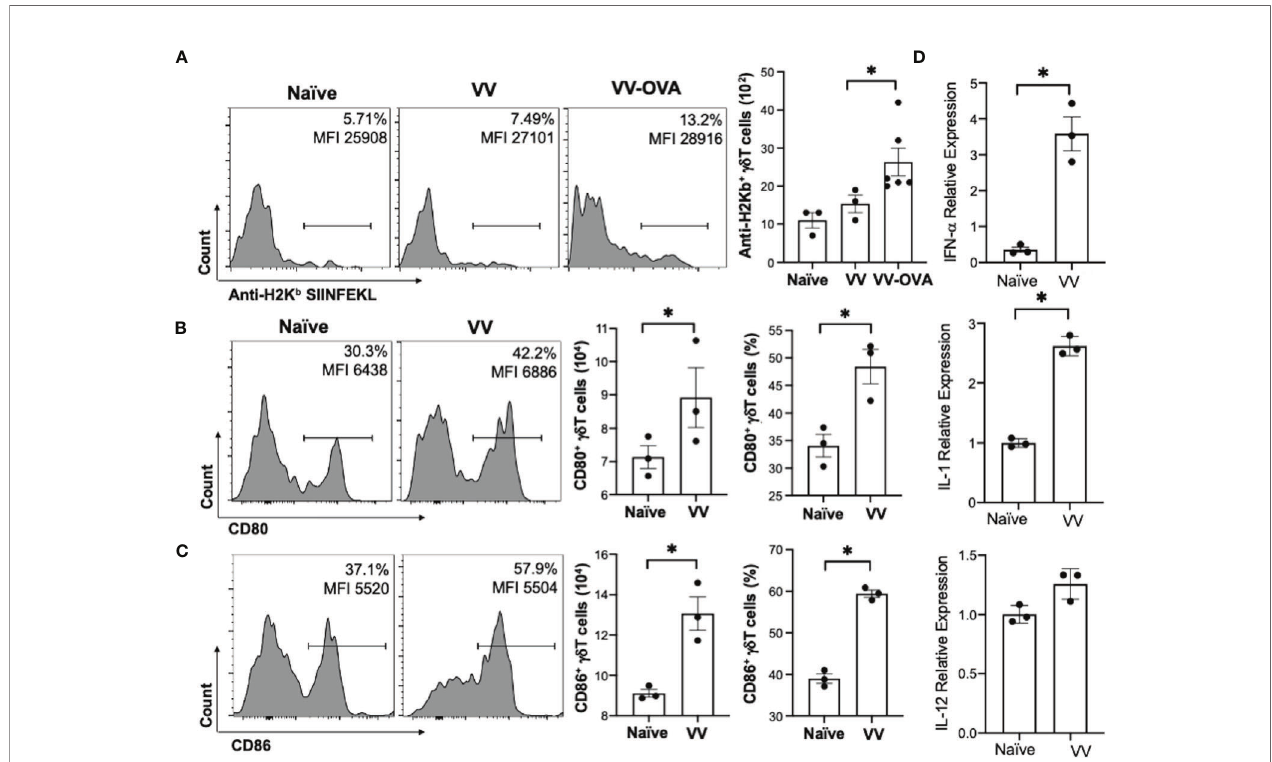
FIGURE 3 | VV activates gd T cells to present peptide on MHC-I and upregulate CD80/CD86 expression. C57BL/6 mice were inoculated intraperitoneally with 5 x 10 6 pfu of VV or VV encoding OVA (VV-OVA). (A) Representative FACS plots fi rst gated on CD3e + and gd TCR + T cells, and then assessed for SIINFEKL peptide expression on mouse MHC-I H2K b via anti-H2K b SIINFEKL in spleens harvested 2 days post-infection. (B, C) 4 days post-inoculation, splenocytes were extracted and stained for CD3e + and gd TCR + T cells. The gated cells were then assessed for (B) CD80 and (C) CD86 expression. (D) 4 days following VV inoculation, gd T cells were isolated from splenocytes from naïve and VV-inoculated WT mice with MACS. Total RNA was extracted from the isolated cells and assessed by qRT-PCR for IFN-a, IL-1, and IL-12 expression. Values are mean ± SEM, representative of 3 independent studies, each with at least 3 biological replicates. ANOVA with post-hoc t-test, * P <